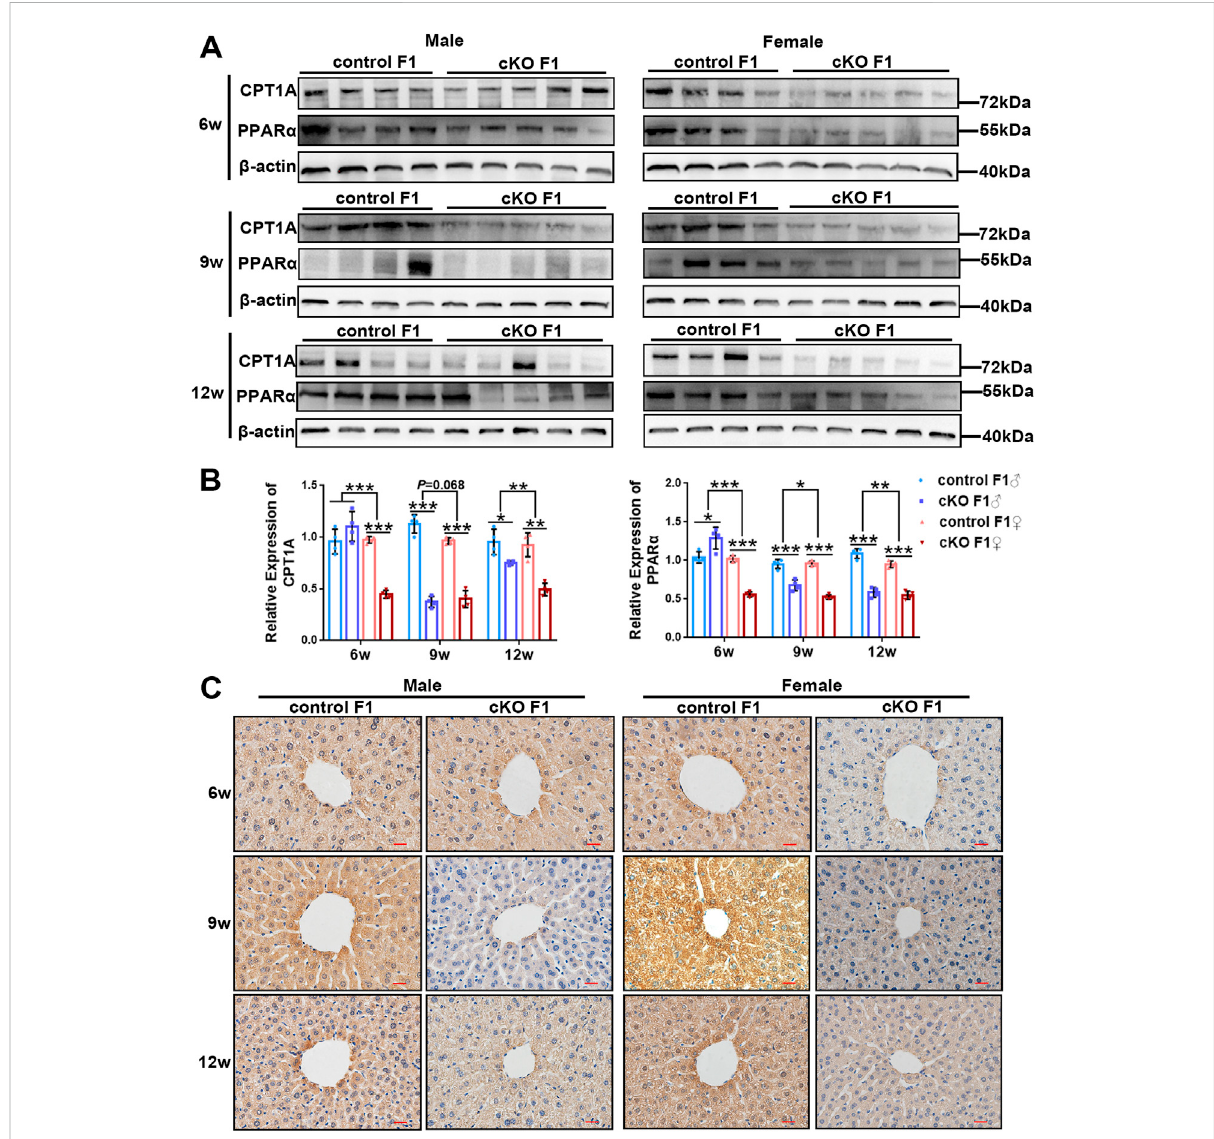
FIGURE 8 The expression of key lipid metabolism factors in the liver was down-regulated in the F1 generation of endometrial DNMT3B conditional knockout female mice (A) The expression of CPT1A and PPAR α in the liver of control and cKO F1 mice was measured using western blotting at 6- weeks, 9-weeks and 12-weeks of age (n = 4 – 5). (B) Relative expression of CPT1A and PPAR α . β -actin was used as the standard to calibrate the gray value of each sample. (C) The expression of CPT1A was measured using immunohistochemistry. Results are presented as mean ± SEM. * p